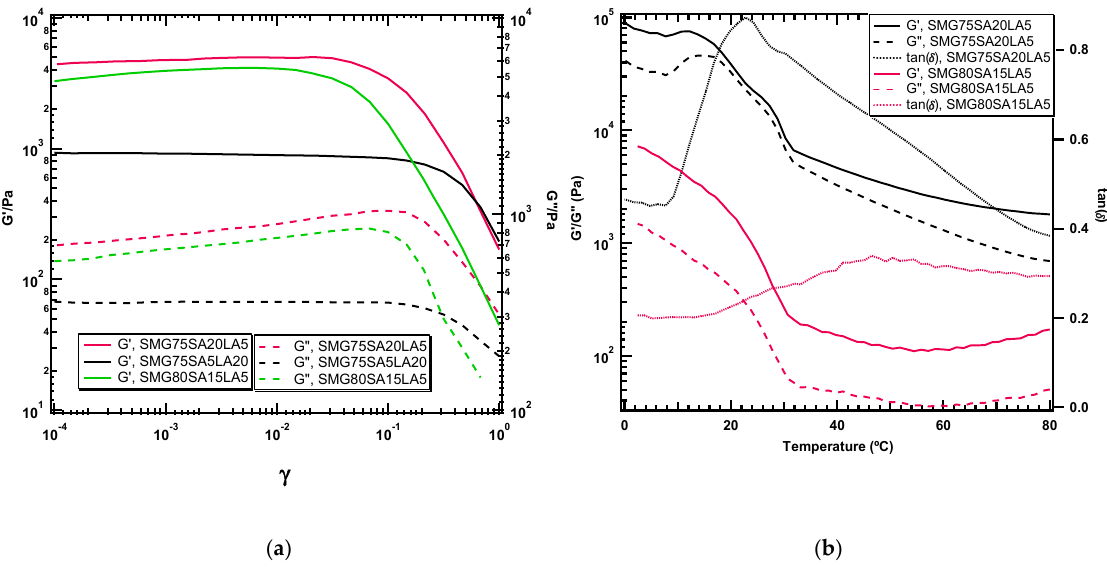
Figure 5. ( a ) The storage (G ′ ) and loss (G ″ ) modulus at 10 rad/s for SMG samples as a function of the applied strain ( b ) Temperature-sweep analysis of the gel samples.